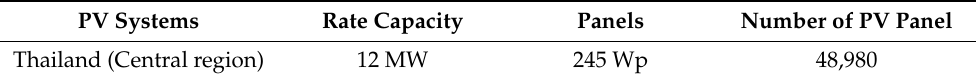
Table 5. Information about the PV systems for the